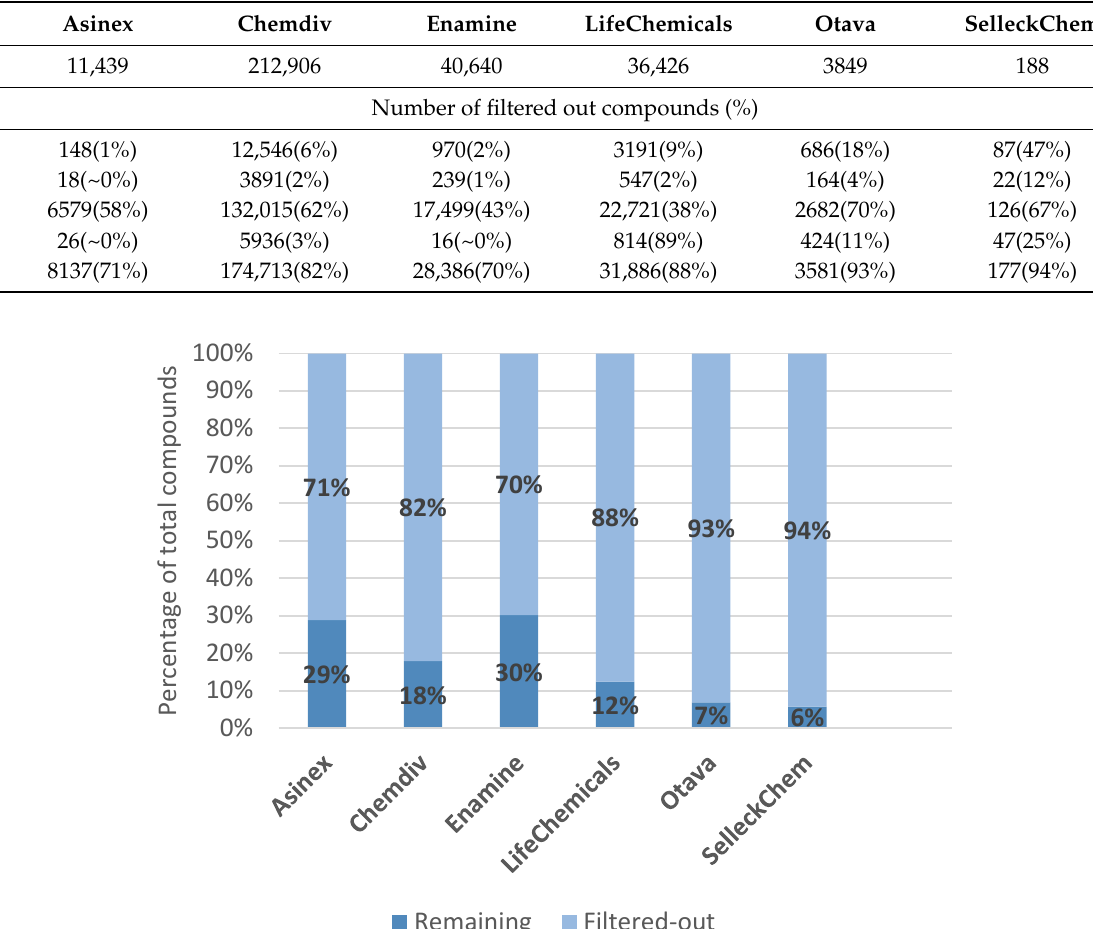
Table 7. Analysis of the attrition rate of various filters for the protein–protein interaction inhibitor library.